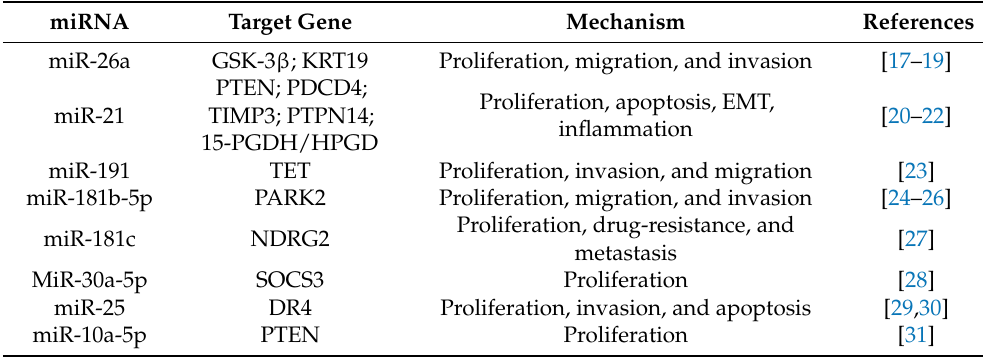
Table 1. MiRNAs acting as onco-miRNAs in BDC: their targets and molecular function. miRNA Target Gene Mechanism